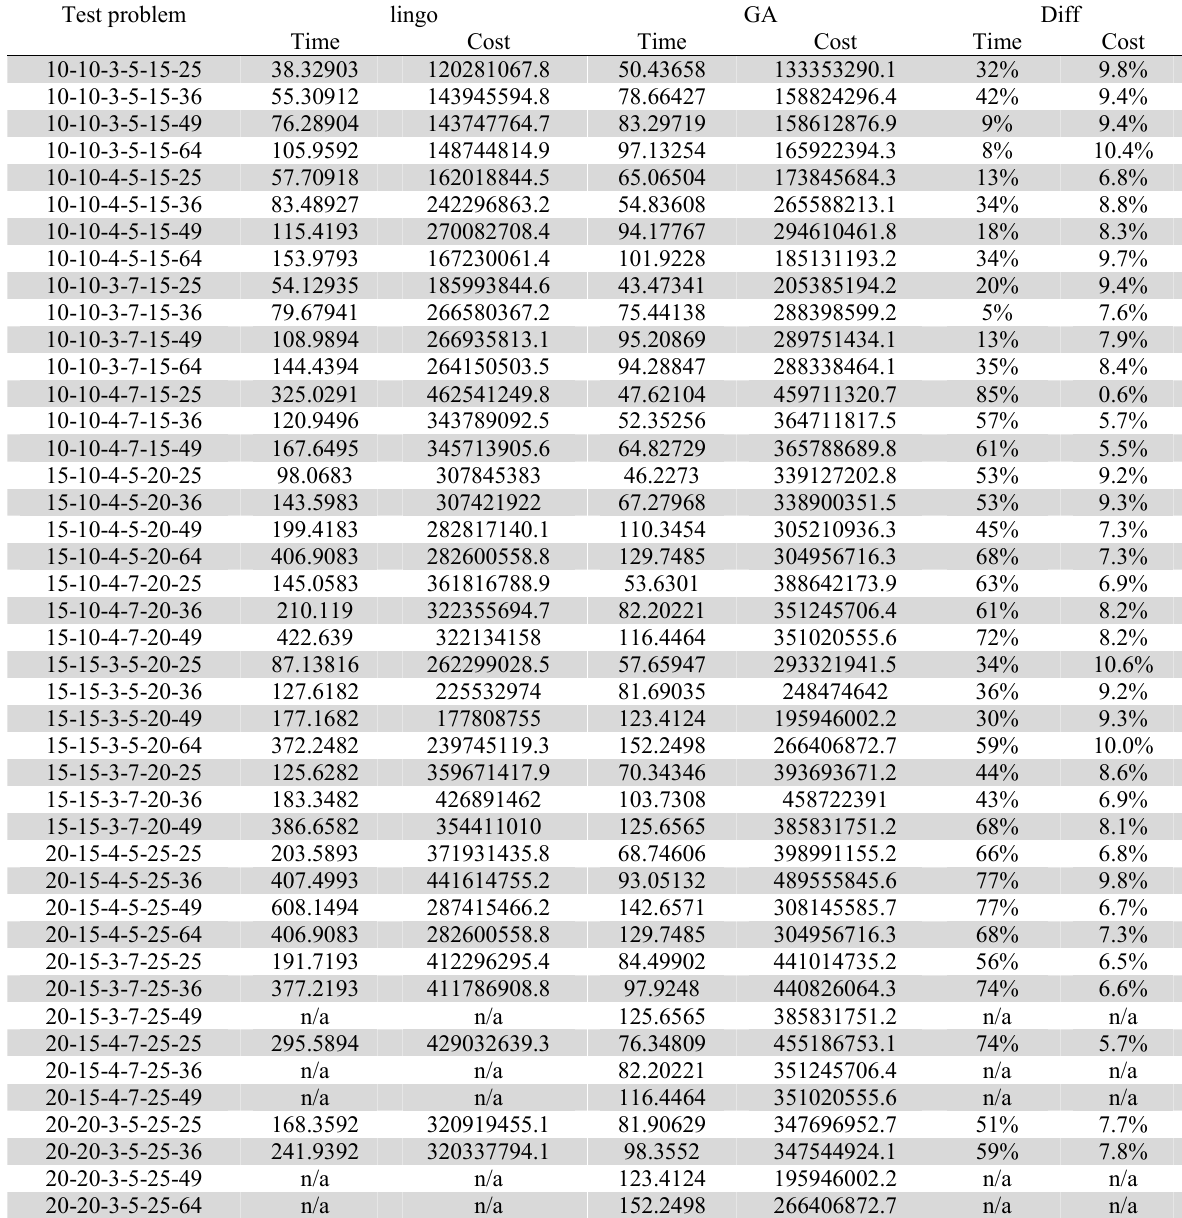
Algorithm performance – vs. LINGO Test